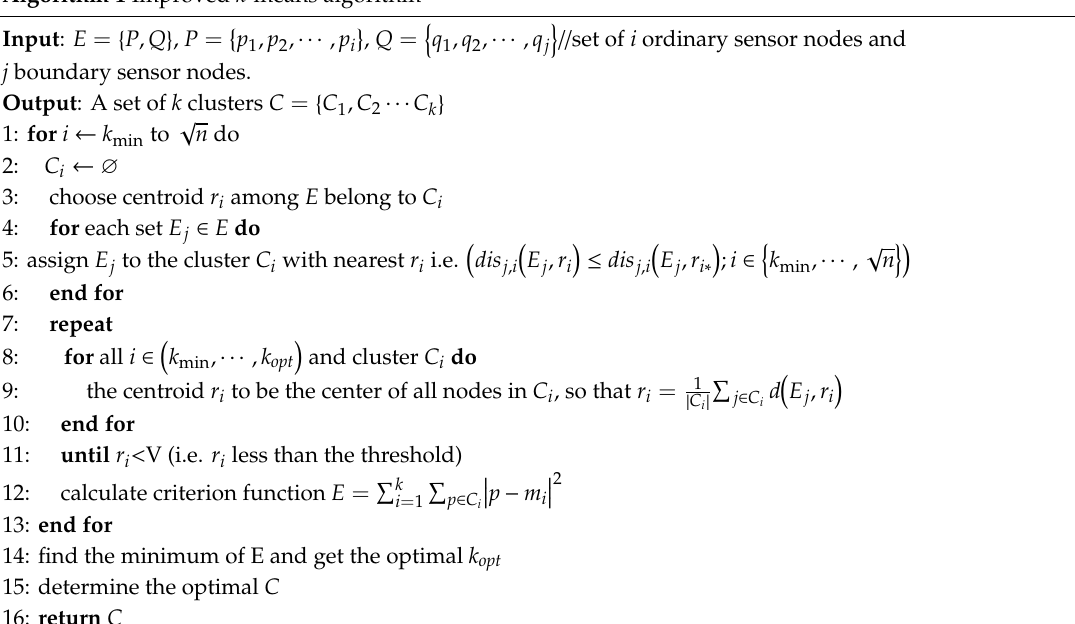
Algorithm 1 Improved k -means